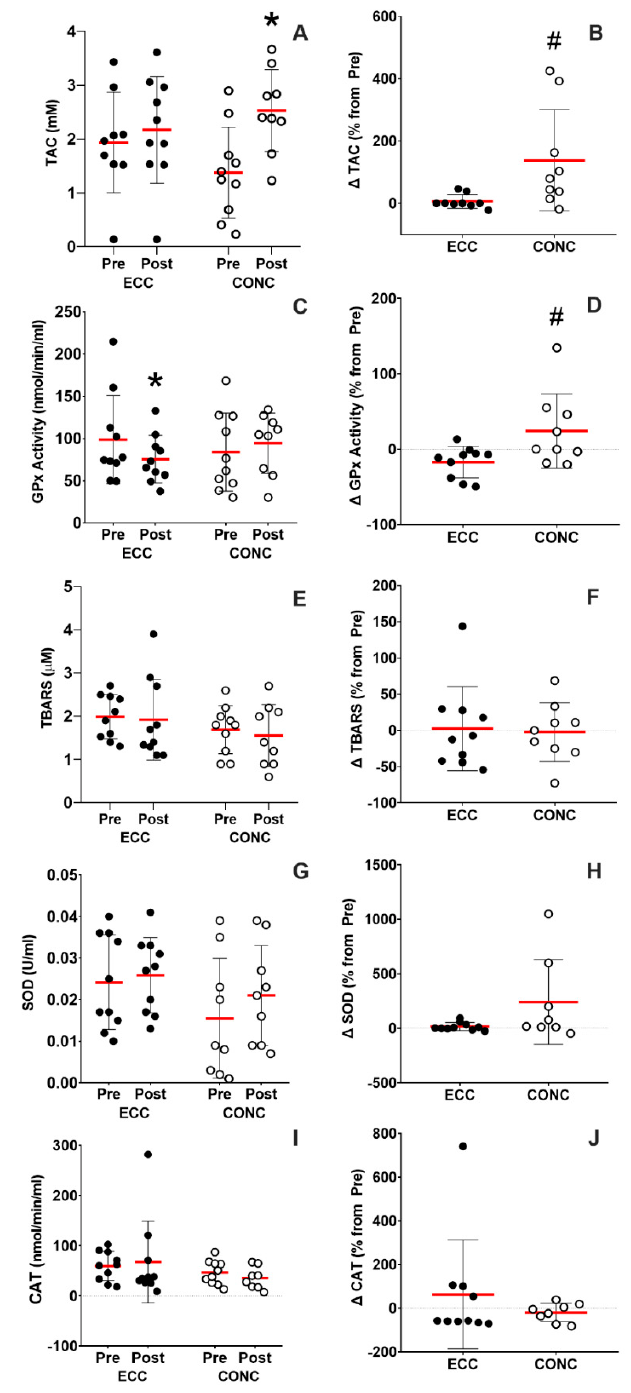
Figure 2. Oxidative stress at rest. Total antioxidant capacity (TAC) levels in absolute values ( A ) as percentage of change from pre-training values ( B ). Glutathione peroxidase activity (GPx) in absolute values ( C ) as percentage of change from pre-training values ( D ). Thiobarbituric acid reactive substances (TBARS) levels in absolute values ( E ) as percentage of change from pre-training values ( F ). Superoxide dismutase (SOD) levels in absolute values ( G ) as percentage of change from pre-training values ( H ). Catalase (CAT) levels in absolute values ( I ) as percentage of change from pre-training values ( J ). ECC: eccentric cycling, CONC: concentric cycling. *: p < 0.05 vs. Pre-. #: p < 0.05 ECC vs.